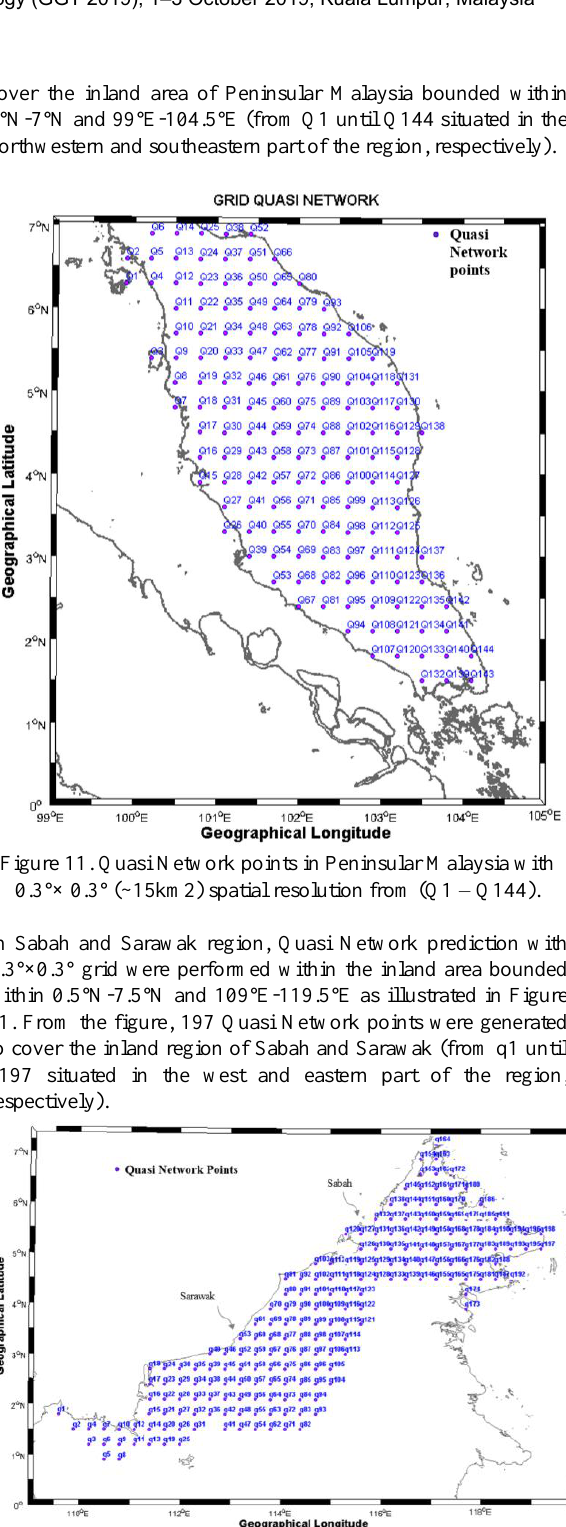
Figure 11. Quasi Network points in Sabah and Sarawak with 0.3°× 0.3° (~15km2) grid from q1 – q197. Figure 12 illustrates the variability of these compression and Table 2. The difference between observed and computed extension at Quasi Network points during the period within the velocities for ten (10) sites in Sabah and Sarawak region from Peninsular Malaysia region Red and blue crosses represent the year 2012 compression and extension, respectively at location of Quasi Network. The Quasi Network point denoted by Q1-Q144 in Quasi Network points in Peninsular Malaysia were generated at black and grey font represents ‘ideal’ and ‘remote’ points, 0.3°×0.3° or 15km2 of spatial resolution. As illustrated in Figure 11, there are 144 Quasi Network points generated to